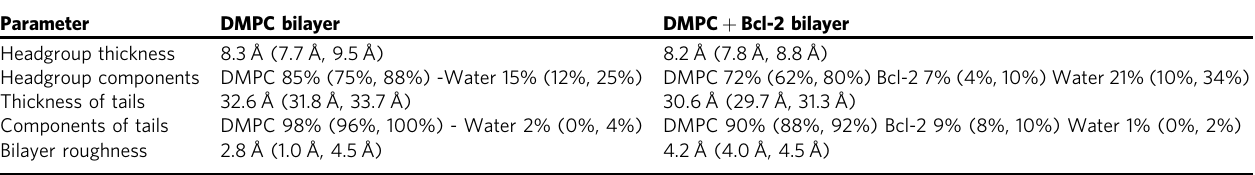
Table 1 Structural parameters for supported DMPC bilayers prior to and in the presence of the Bcl-2 protein.